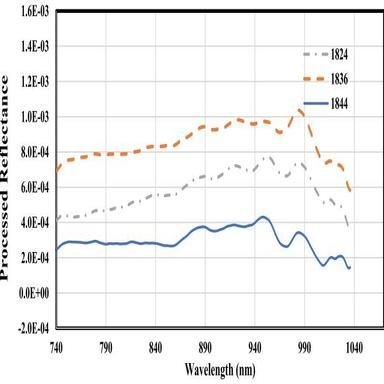
Comparing three SMA mixtures modified with SBS.